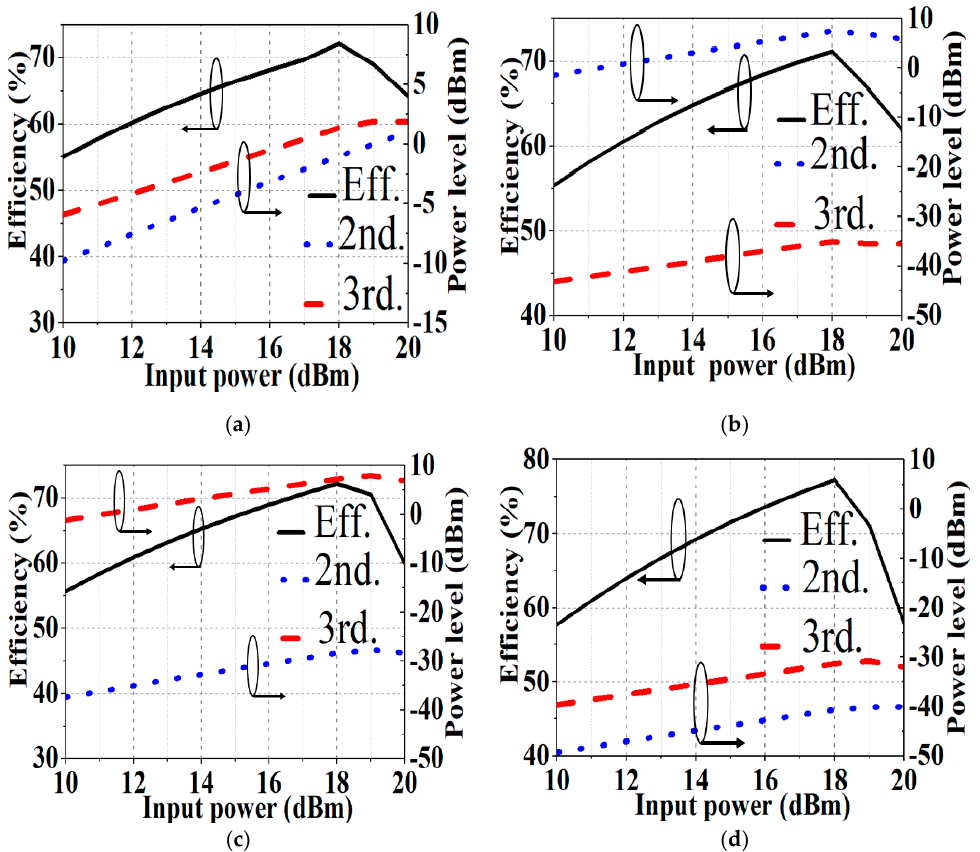
Figure 5. Simulated rectifying efficiency and the harmonic amplitude of different rectifiers at different input powers: ( a ) the rectifier utilizing both the 2nd and 3rd harmonics; ( b ) the rectifier utilizing the 2nd harmonic; ( c ) the rectifier utilizing the 3rd harmonic; ( d ) the harmonic suppression rectifier.